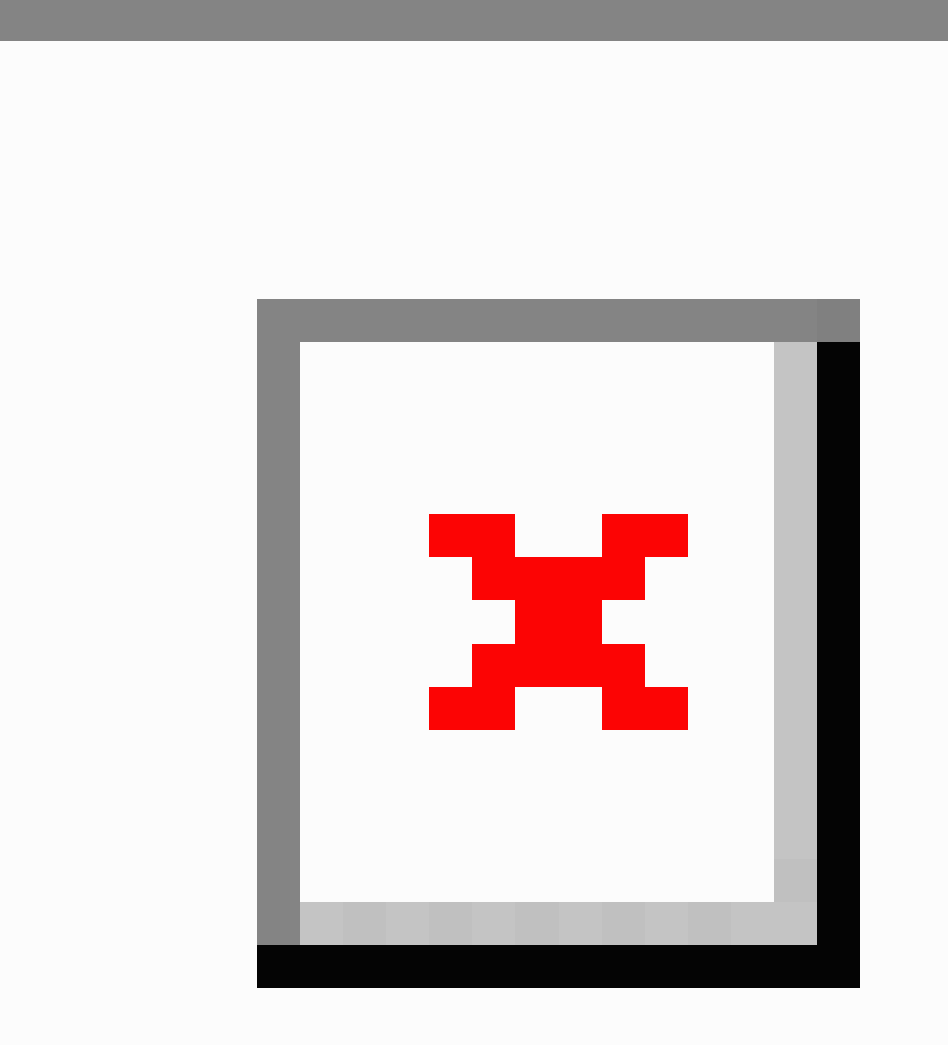
Figure 4. Mean change of physical activity duration in the control and app groups